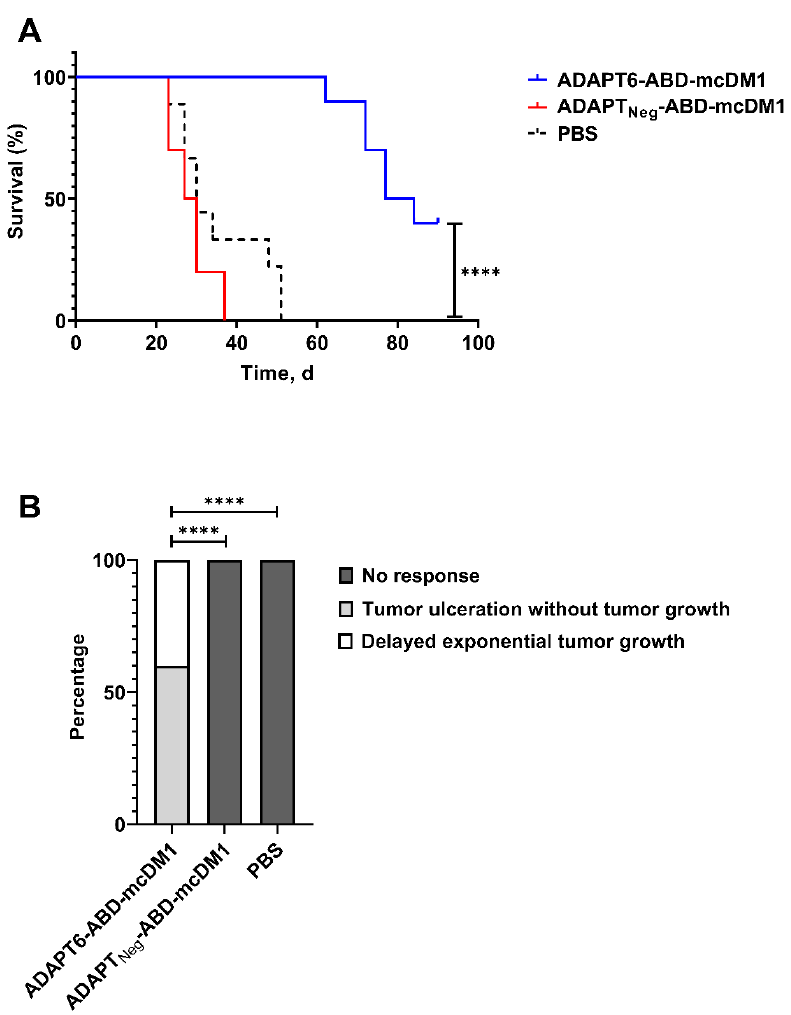
Figure 3. ( A ) Survival of BALB/c nu/nu mice bearing SKOV3 xenografts treated with ADAPT6-ABD- mcDM1, ADAPT Neg -ABD-mcDM1 or PBS (vehicle). ( B ) Therapy outcomes for different treatment groups. The output categories were defined as no response (exponential tumor growth), delayed exponential tumor growth and controlled tumor growth (tumor ulceration without tumor growth). The difference between groups was determined using chi–square test. **** corresponds to p < 0.0001. The treatment was well tolerated, with no observable side effects. No tendency for weight loss was observed in the ADAPT6-ABD-mcDM1 group compared to the ADAPT- Neg -ABD-mcDM1 group or the PBS group. The differences in average animal weight be- tween the groups were within one standard deviation (Figure 4).